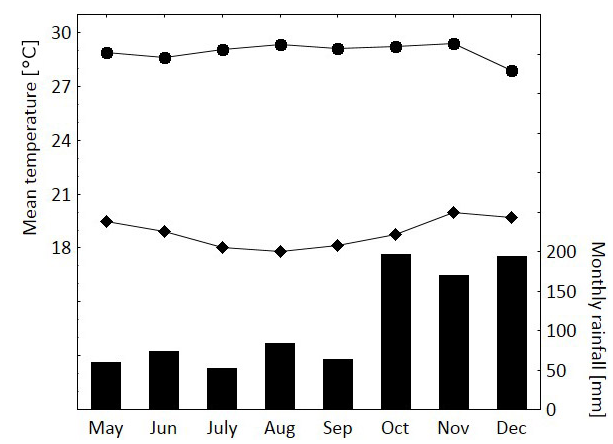
Figure 2. Mean daily maximum temperature ( • ), mean daily min- imum temperature ( (cid:7) ) and total monthly rainfall (bars) during the study period May–December 2014. Data from http://www.senamhi. gob.pe/main_mapa.php?t=dHi (accessed 5 April